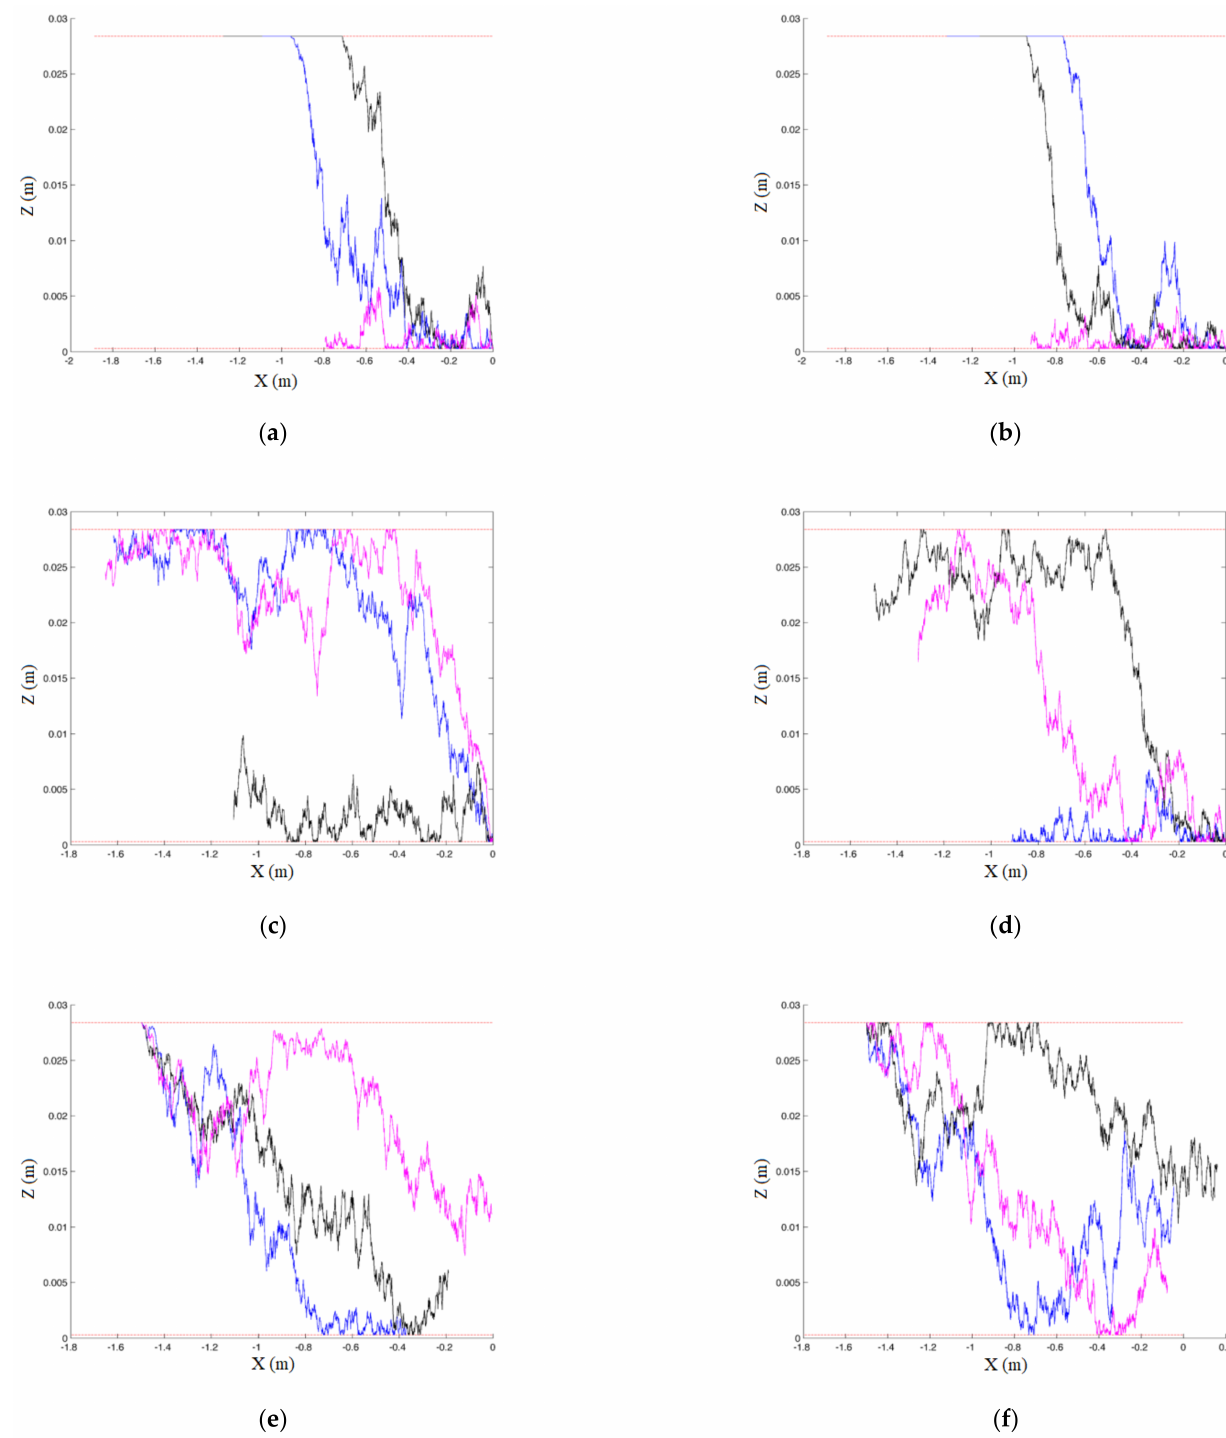
Figure 1. Sample paths randomly selected from 10,000 simulations: ( a ) sample paths of backward tracking tests with the diffusivity of Rouse [37], using the explicit method; ( b ) sample paths of backward tracking tests with the diffusivity of Rouse [37], using the implicit method; ( c ) sample paths of backward tracking tests with the diffusivity of Absi et al. [38], using the explicit method; ( d ) sample paths of backward tracking tests with the diffusivity of Absi et al. [38], using the implicit method; ( e ) sample paths of forward tracking tests with the diffusivity of Rouse [37], using the explicit method; ( f ) sample paths of forward tracking tests with the diffusivity of Absi et al. [38], using the explicit